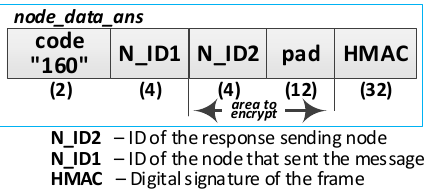
Figure 33. Response to the data frame.